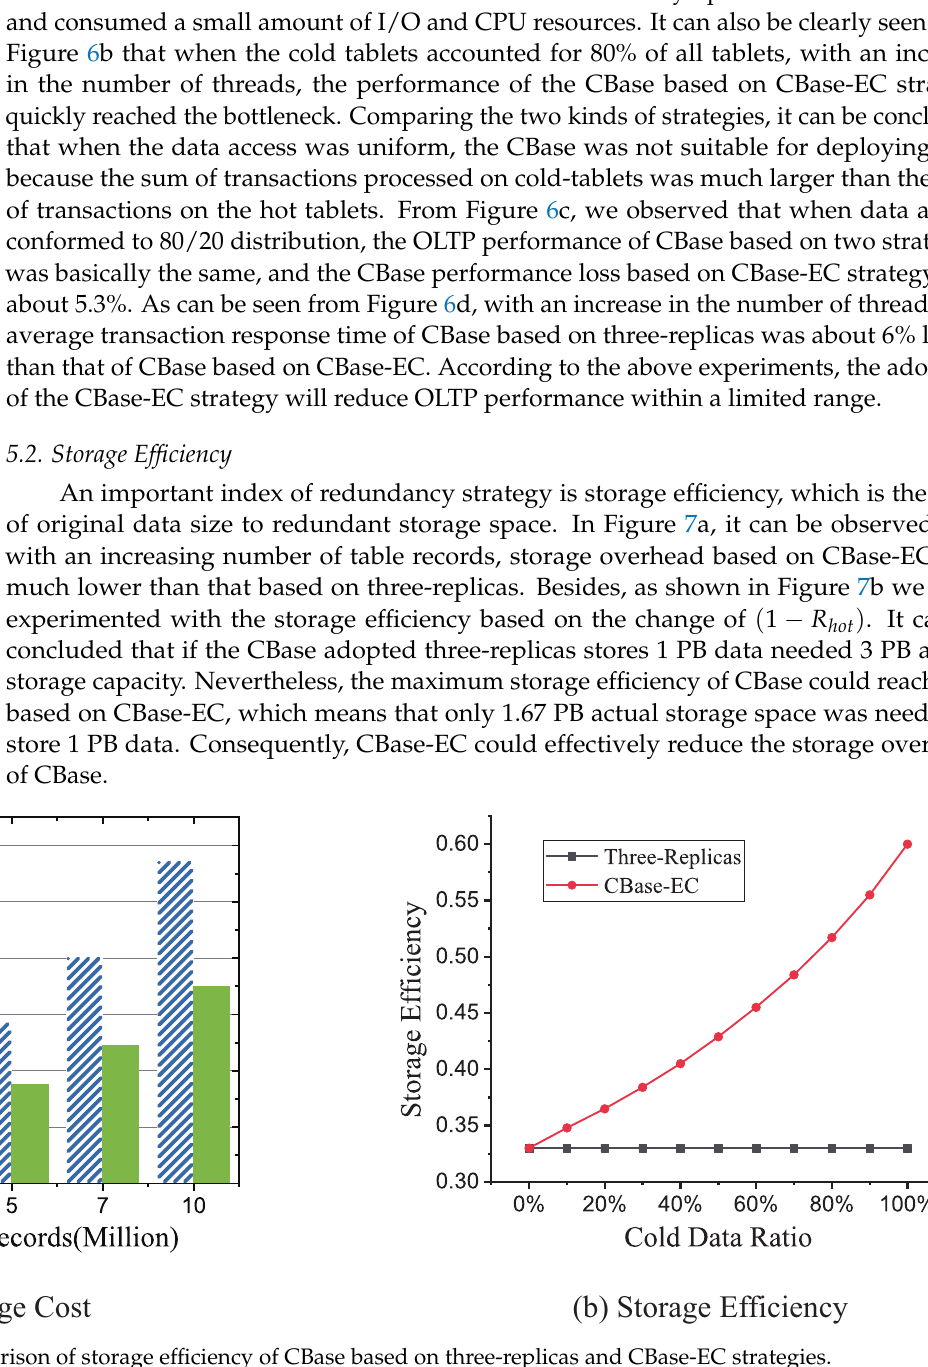
Figure 7. Comparison of storage efficiency of CBase based on three-replicas and CBase-EC